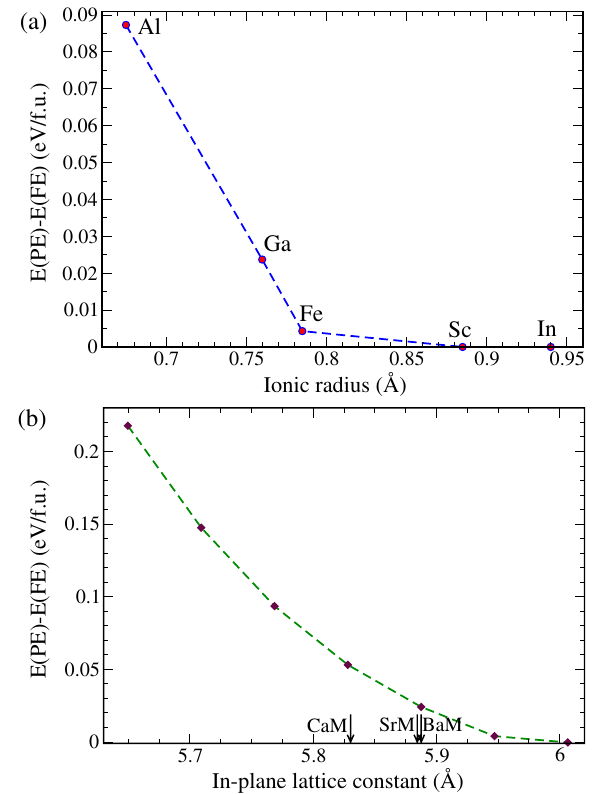
FIG. 4 Stability of the FE distortion. (a) The energy difference between the PE and FE states as a function of the radius of the þ 3 ion at the TBP Fe 3 þ ion sites. (b) The energy difference between the PE and FE states as a function of the in-plane lattice constant. The out-of-plane lattice vector is fully optimized. The exper- imental in-plane lattice constants [10,23] of AFe 12 O 19 with A ¼ Ca, Sr, Ba are denoted by